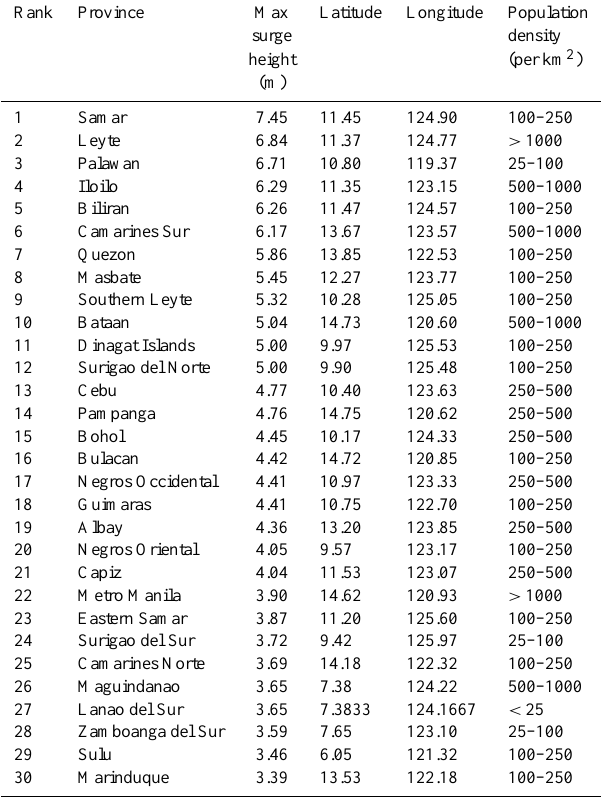
Table 1. Top 30 provinces and cities with a high storm surge level and LECZ population